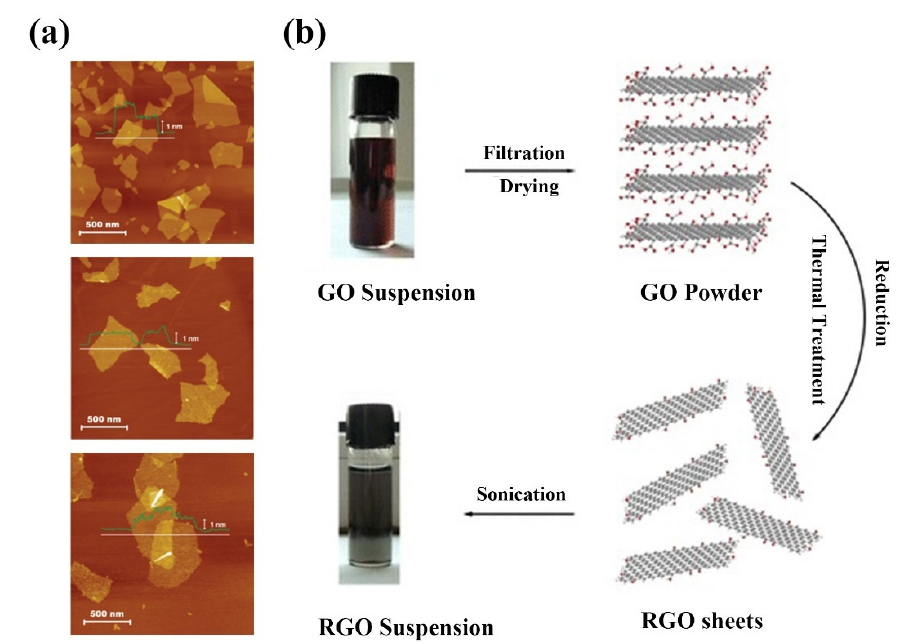
Figure 5. ( a ) AFM images of unreduced ( top ), hydrazine-reduced ( middle ), and vitamin c-reduced ( bottom ) GO flakes deposited from the corresponding suspensions onto the substrate. Reprinted with permission from Ref. [82]. Copyright 2010, American Chemical Society. ( b ) Schematic diagram of rGO suspension prepared by the low-temperature thermal treatment. Reprinted with permission from Ref. [85]. Copyright 2017, Springer Nature.